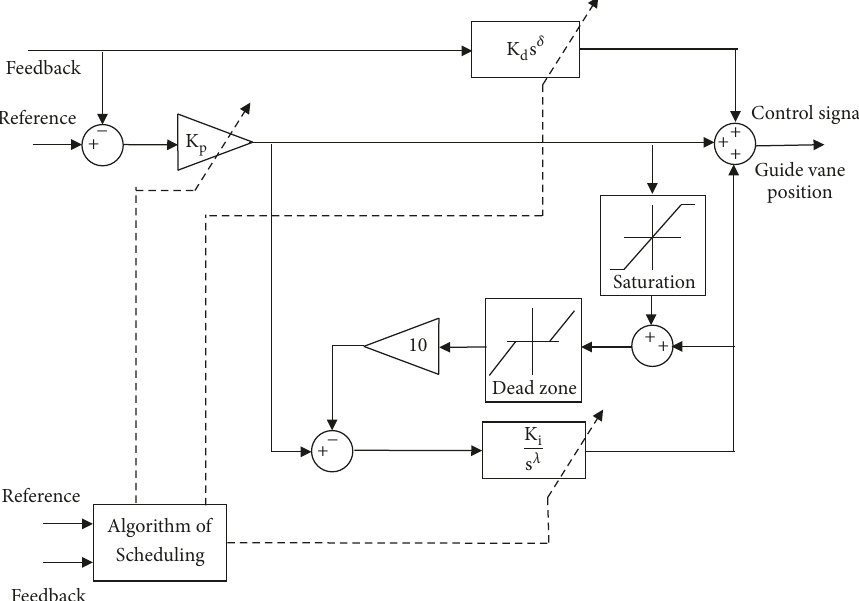
Figure 7: General structure of the antiwindup FO-PDF gain scheduling